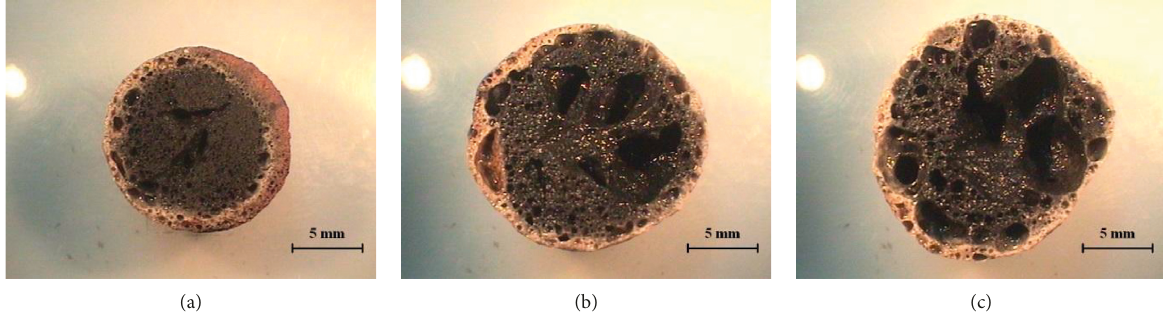
Figure 6: Microstructure image of the lightweight aggregate by rapid sintering. (a) 1100 ° C. (b) 1140 ° C. (c) 1180 °